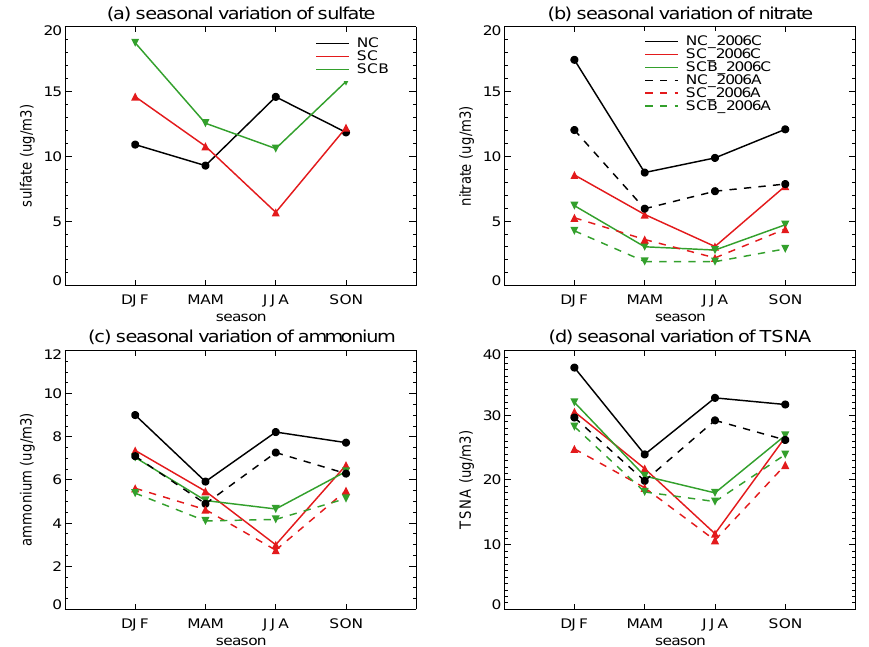
Fig. 10. Simulated seasonal mean concentrations of (a) sulfate, (b) nitrate, (c) ammonium and (d) TSNA over NC, SC and SCB. The black lines represent NC, red lines represent SC and green lines represent SCB. The solid lines represent 2006C results and dashed lines represent 2006A